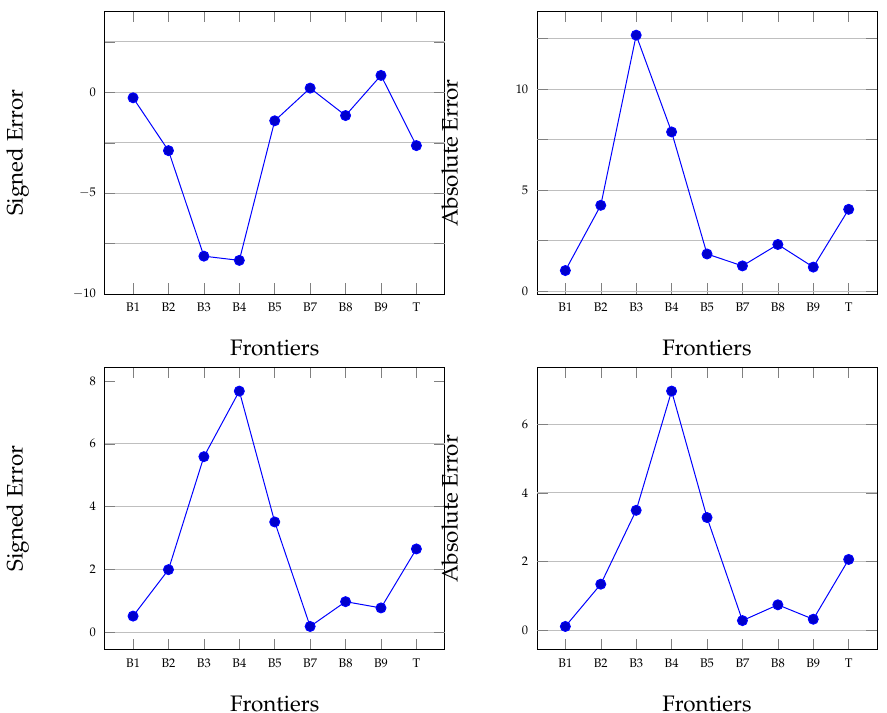
Figure 7. Mean ( top ) and standard deviations ( bottom ) for SE (signed error) and AE (absolute error) for retinas with conditions.